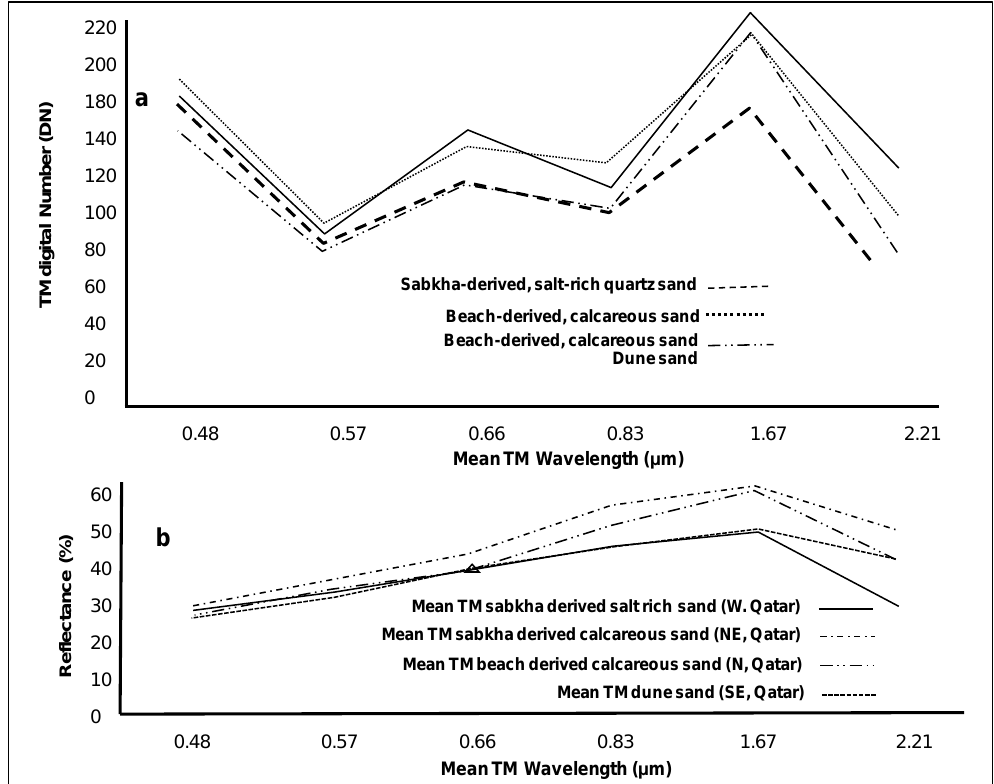
Figure 5. Spectral profiles of: (a) Landsat TM raw digital number (DN) values for the study area and (b) Landsat TM mean spectral reflectance of various sand